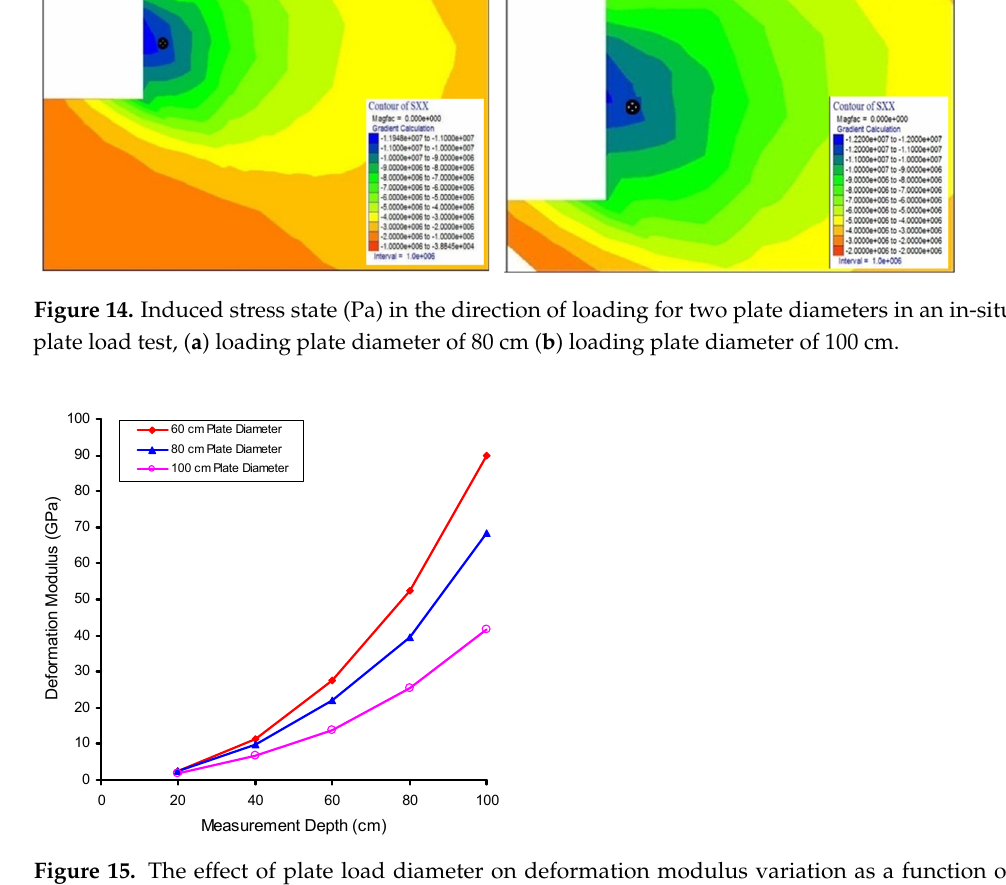
Figure 14. Induced stress state (Pa) in the direction of loading for two plate diameters in an in-situ plate load test, ( a ) loading plate diameter of 80 cm ( b ) loading plate diameter of 100 cm.